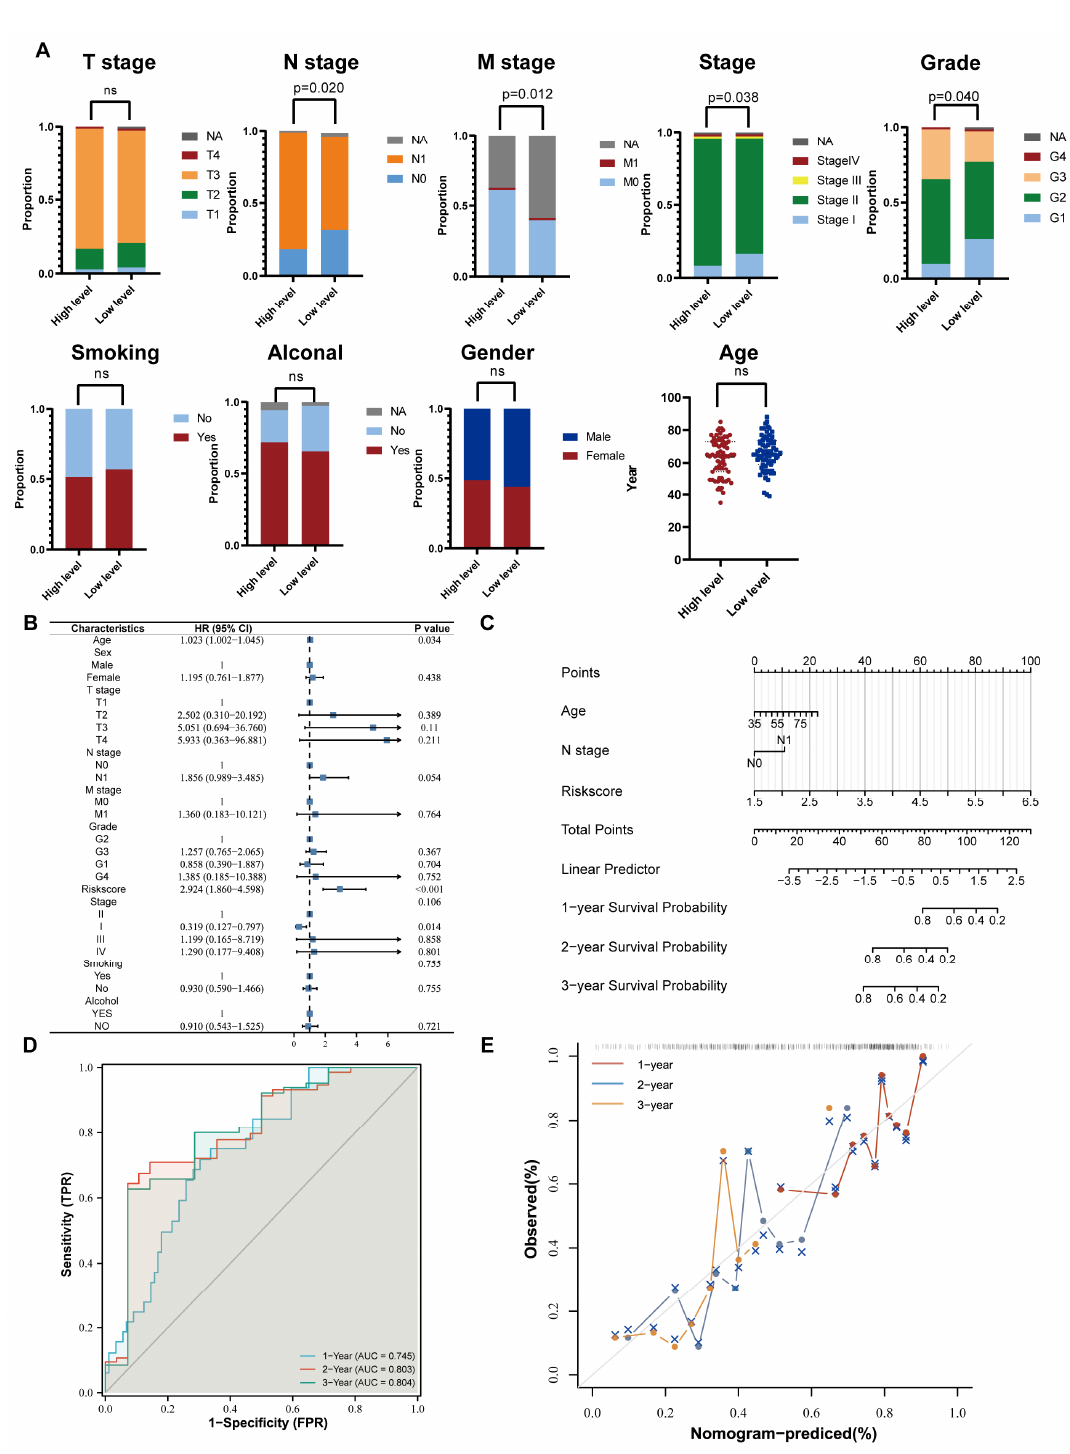
Figure 4. Comparison of clinical features between high- and low-risk groups and development of an OS predictive nomogram. ( A ) The percentage-staked bar plots and boxplot show the distribution of various clinical features between the high- and low-risk groups (“ns” stands for no significant difference between the values from the two groups.). ( B ) Multivariate Cox regression analysis for selection of primary clinical features and risk score correlated with overall survival of PC patients. ( C ) The NMG − based nomogram was constructed to predict the OS of PC patients. ( D ) The ROC curves of the nomogram for OS at 1, 2, and 3 years in the analysis of TCGA − PAAD cohort. ( E ) The calibration plots for the evaluation of predicted OS at 1, 2, and 3